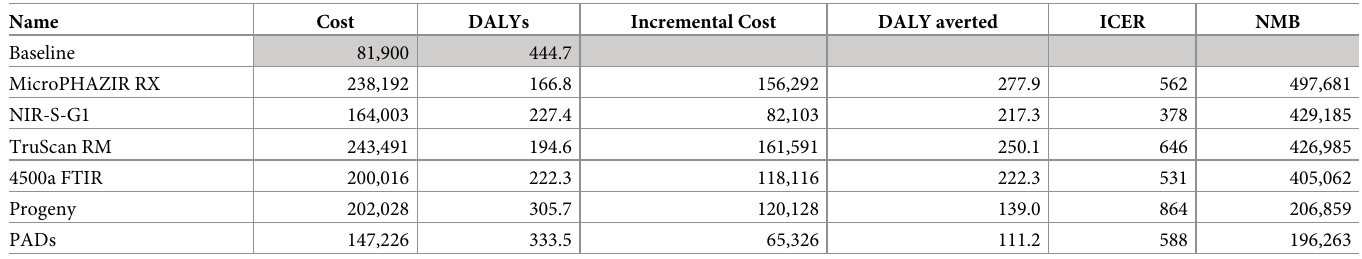
Table 7. Country level costs and effects in sensitivity analysis when using one device per province instead of one per district per device in lower prevalence scenario with a 1-sample strategy compared with visual inspection in descending order of net monetary benefit (NMB, US$). DALY—disability adjusted life year. ICER— incremental cost-effectiveness